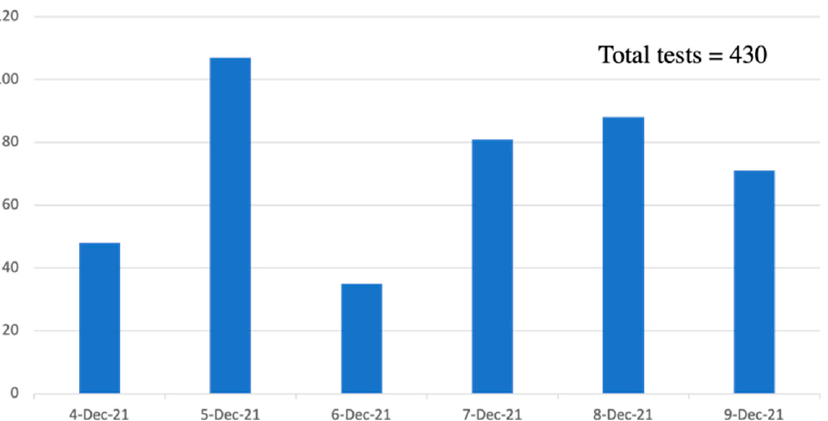
Figure 2. Number COVID-19 rapid antigen tests performed at conference venue. December 4, 2021 (48 tests), December 5, 2021 (107 tests), December 6, 2021 (35 tests), 7 December 2021 (81 tests), 8